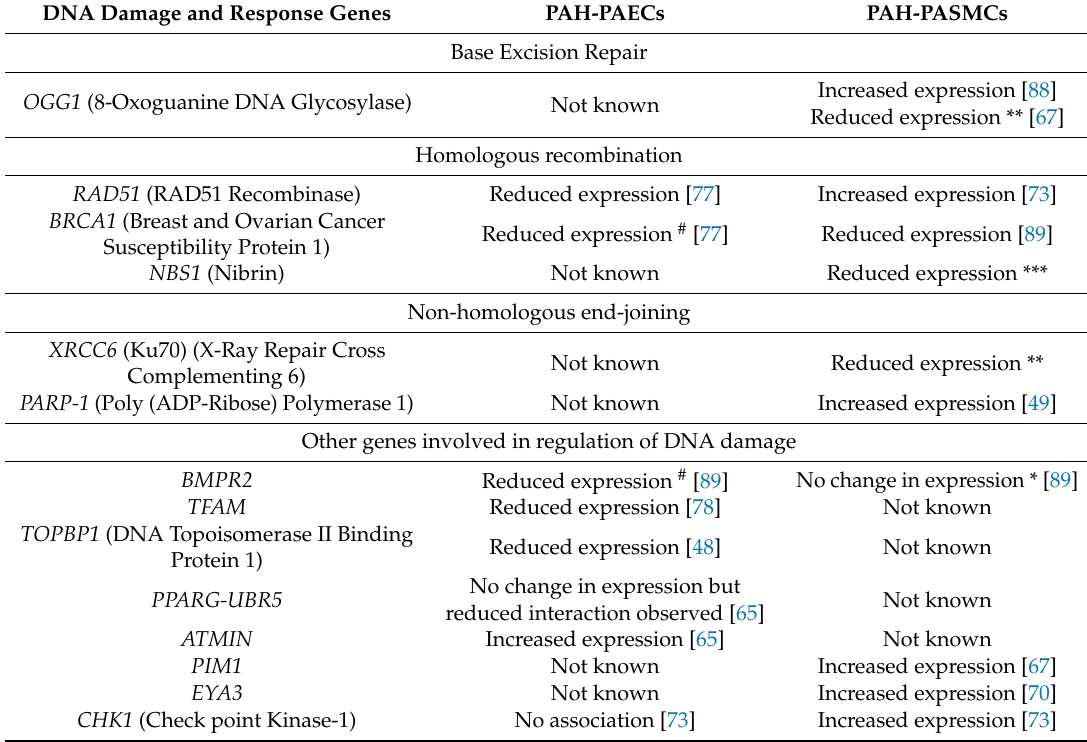
Table 1. Genes associated with the DNA damage and response pathways in pulmonary arterial